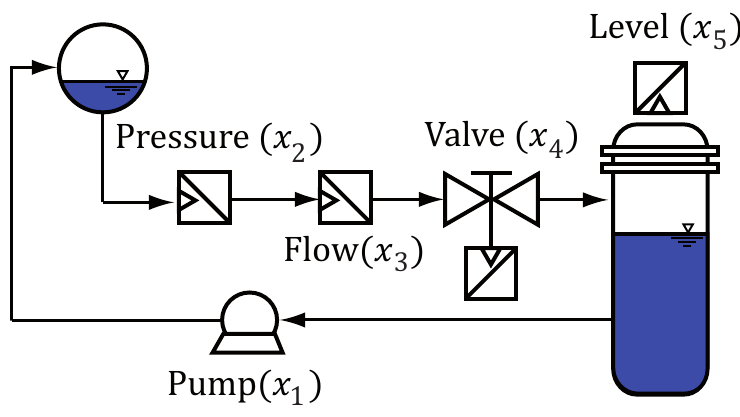
Figure 4. Schematic drawing of the laboratory